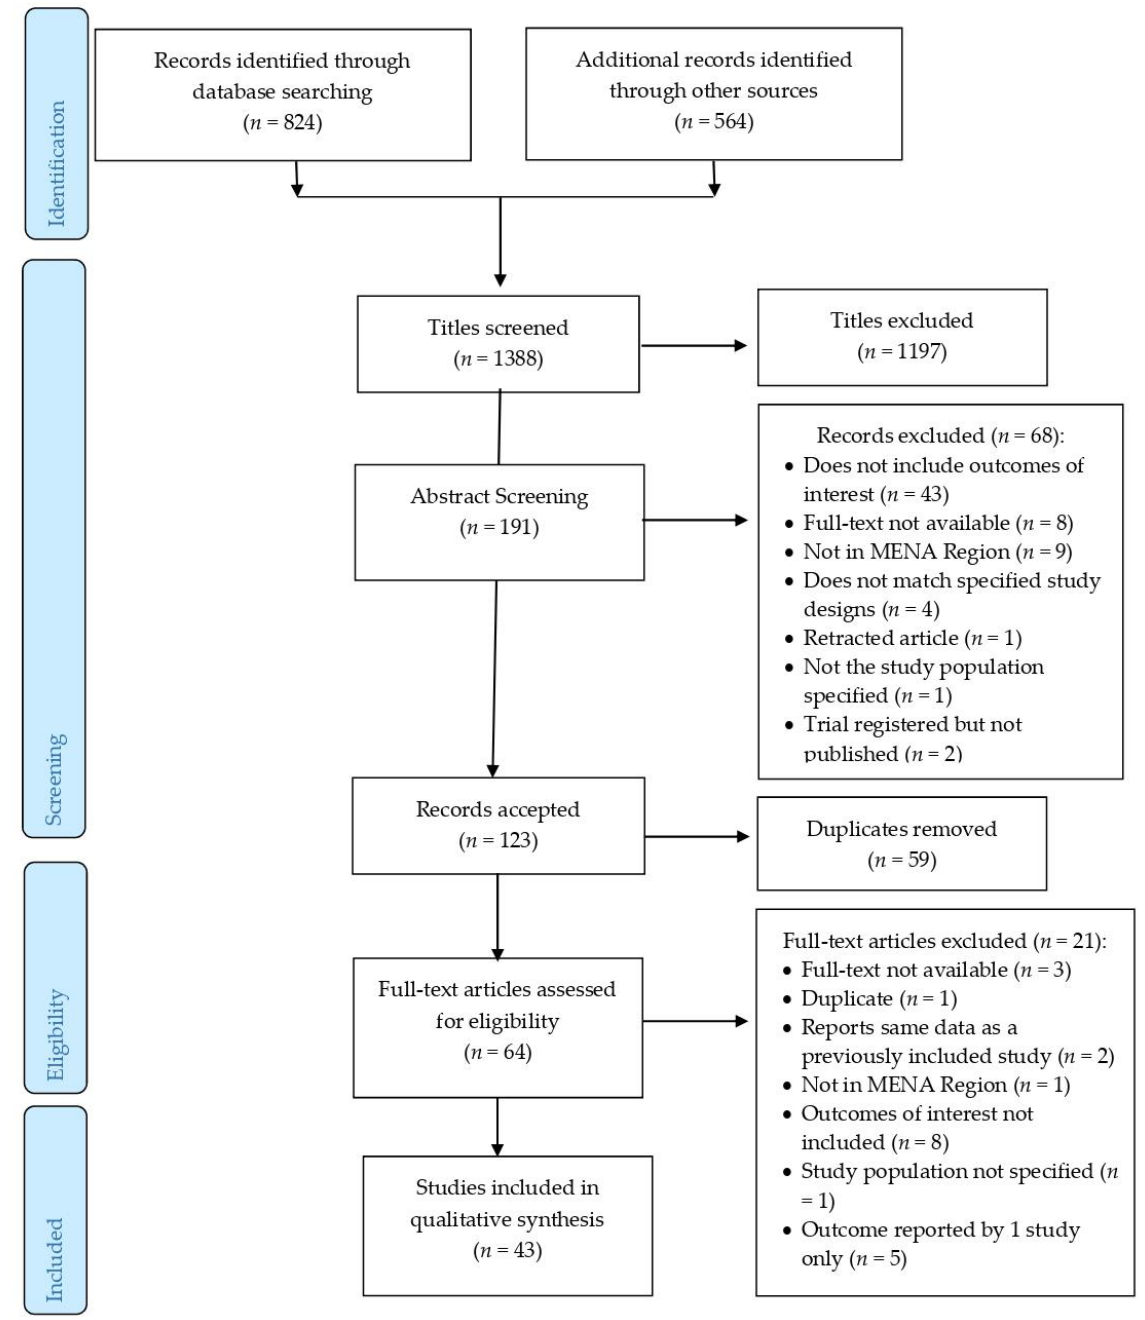
Figure 1. Study selection